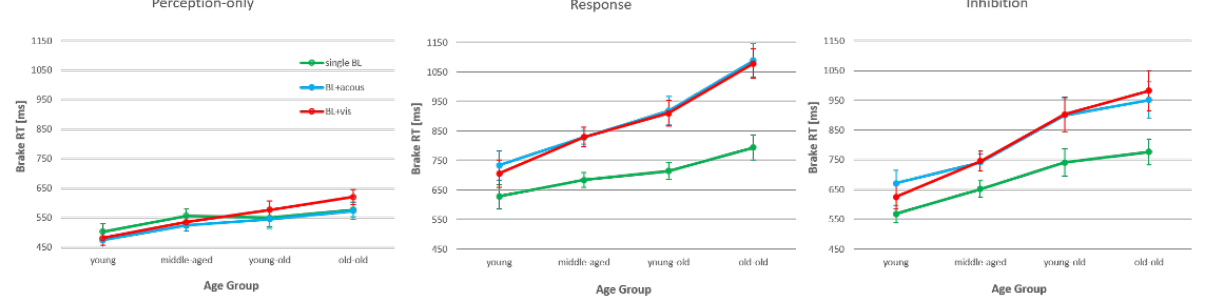
Figure 3. Mean braking RTs and standard errors of mean in trials with single brake light (BL), brake light + acoustic stimulus (BL + acous), and brake light + visual stimulus (BL + vis) of the four age groups, presented separately for perception-only, response, and inhibition task.